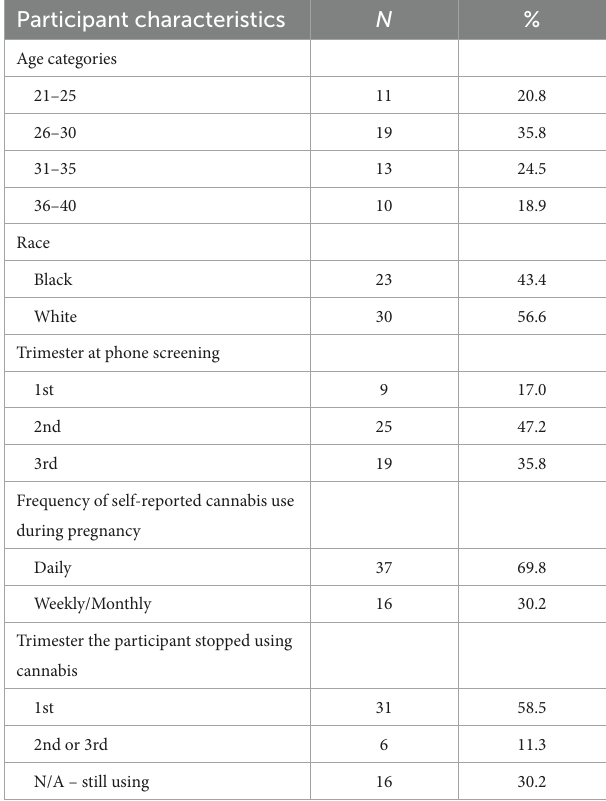
TABLE 1 Characteristics of focus group participants ( N = 53). Participant